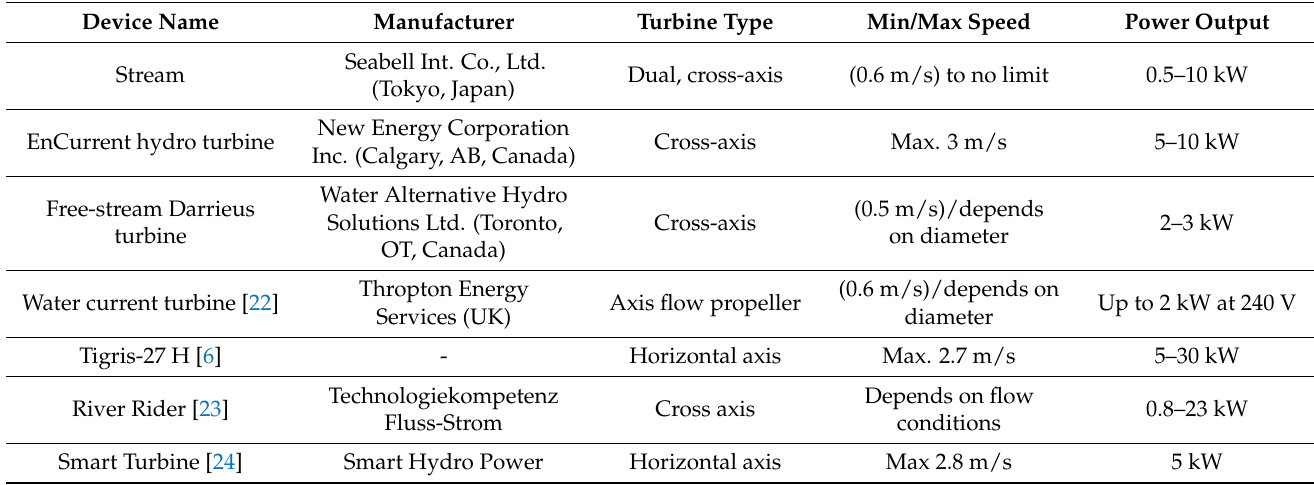
Table 1. Technical specifications of some hydrokinetic